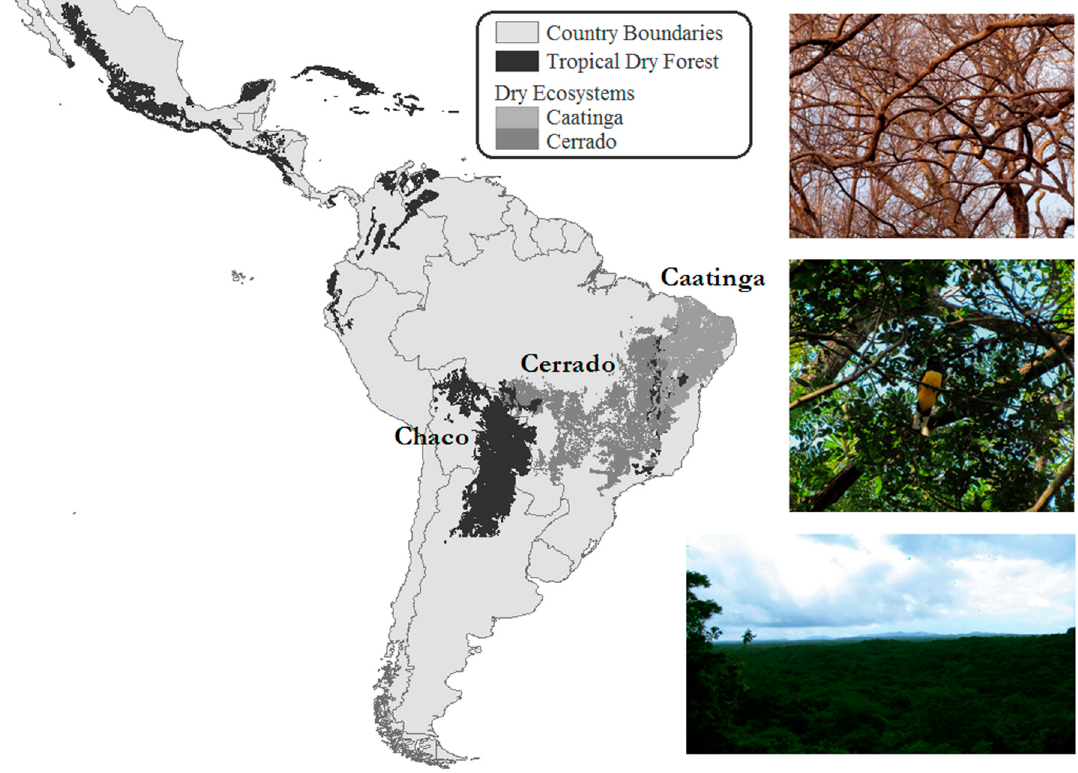
Figure 1. Location of the tropical dry forests (TDFs) in Central and South America. The dry ecosystems also include the Brazilian Cerrado (savanna) and Caatinga (Data from Portillo-Quintero and Sanchez-Azofeifa 2010; photos from Antonio Guzman Quesada).